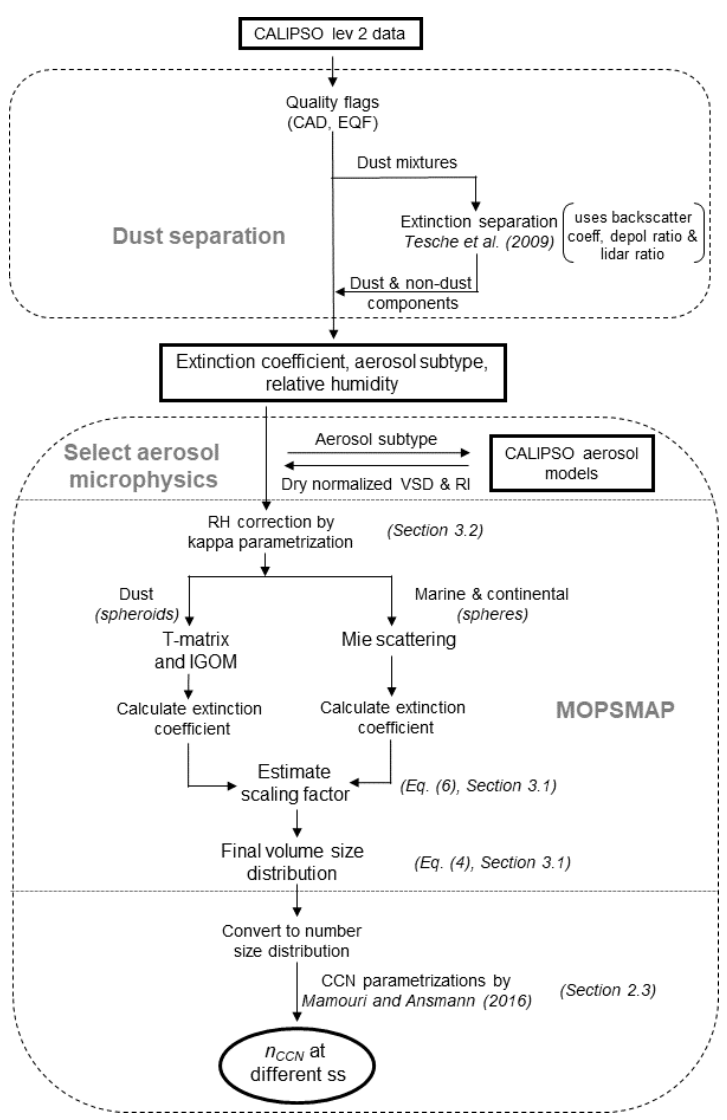
Figure 1. Flowchart of the OMCAM algorithm illustrating important steps involved in retrieving CCN concentrations from CALIPSO level 2 aerosol profile data. The upper part describes the pre-processing to infer information on the extinction coefficient, aerosol subtype, and the relative humidity. These parameters form the input to the CCN retrieval part, which is outlined in the lower part. The chart also refers to the used equations and the sections in which specific parts are